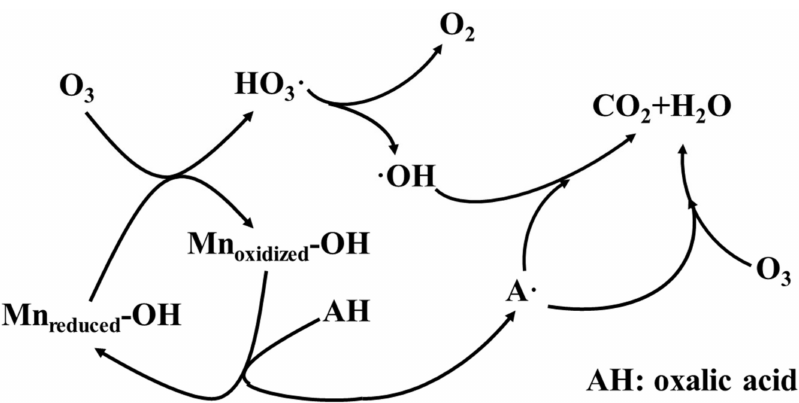
Figure 7. Mechanism of electron transfer between Mn and O 3